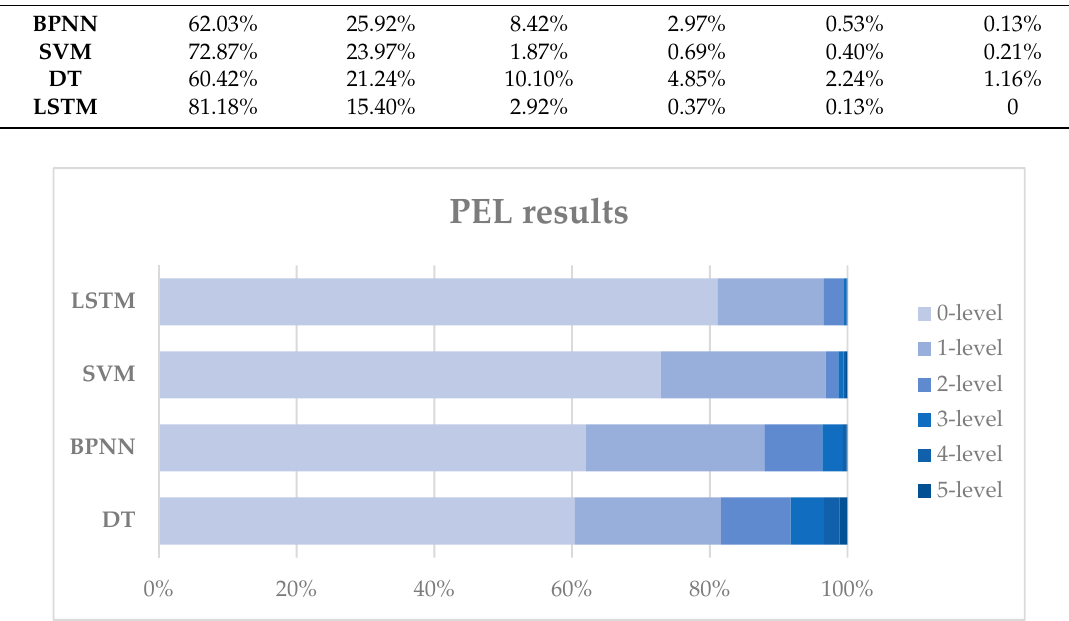
Figure 8. PEL results of the four models.